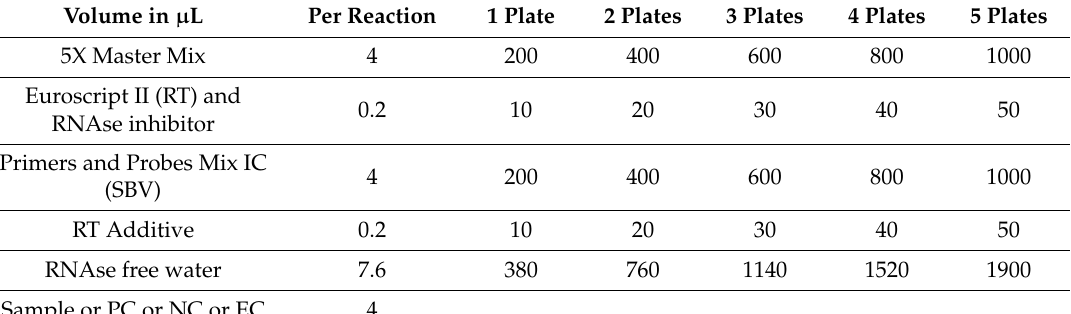
Table 4. Composition of the Internal Control (SBV) PCR